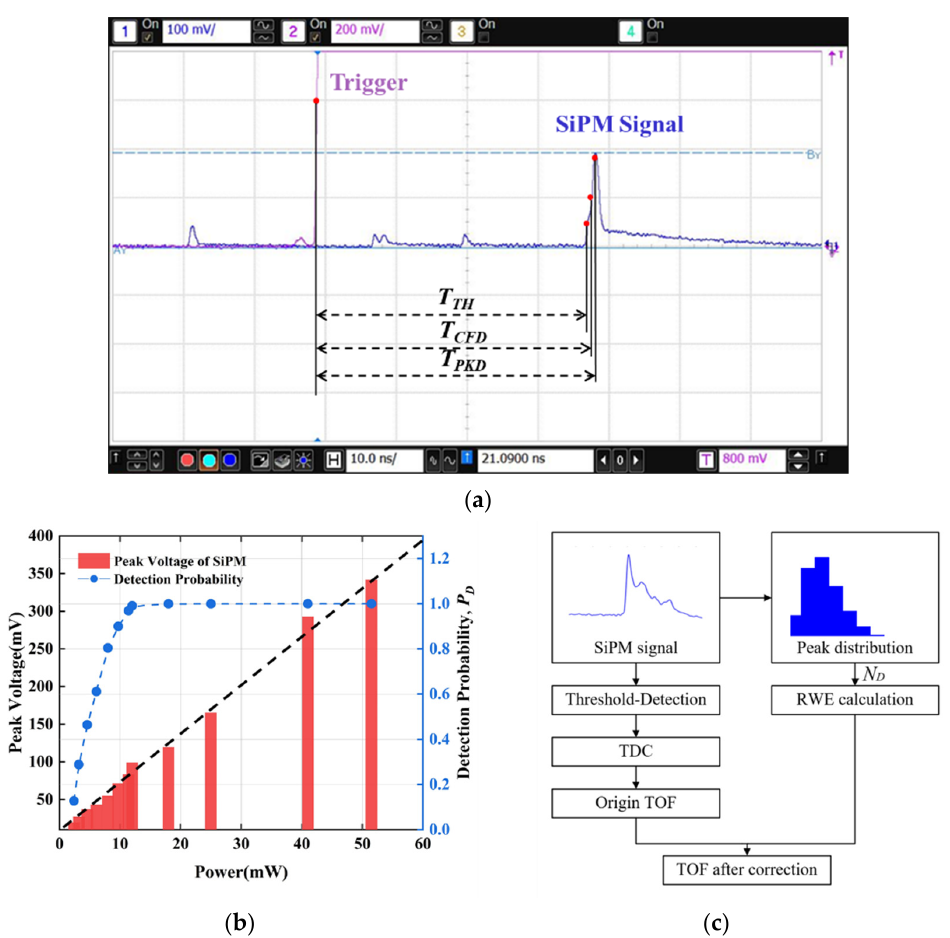
Figure 7. ( a ) The oscilloscope waveform of time-of-flight measurement with the markers of the measured time using fixed threshold, CFD and PKD methods. ( b ) Peak voltage of SiPM and detection probability versus optical power. ( c ) Schematic diagram of range walk error restraint.